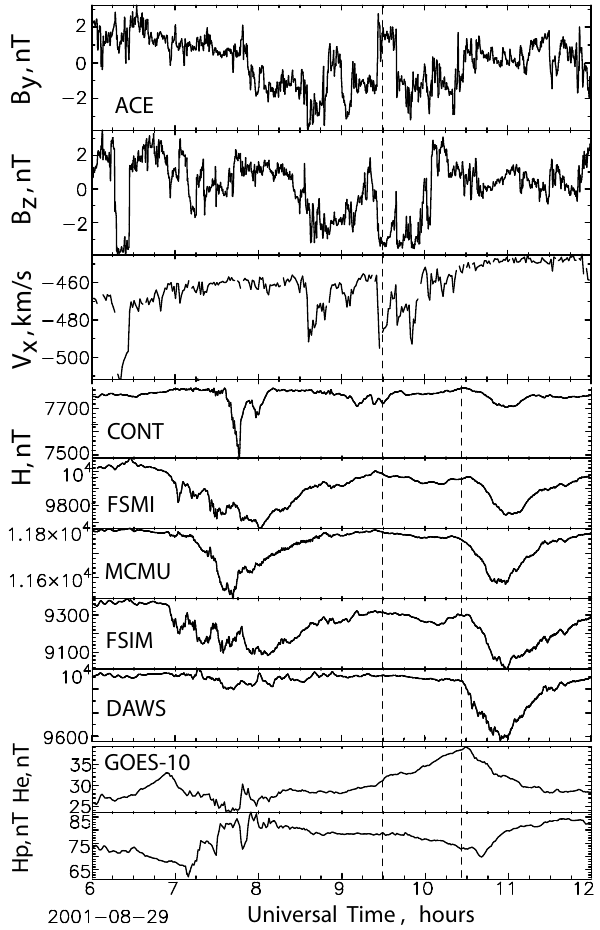
Fig. 2. Solar wind parameters from ACE: X , Y , Z (GSE) IMF com- ponents, proton number density, X -component of proton bulk ve- locity, and ground-based magnetometer data from CANOPUS net- work (Dawson) for 06:00–12:00 UT, 29 August 2001. Dashed lines display the time shift of 53min between ACE and ground-based